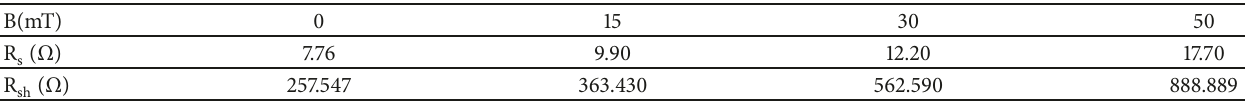
Table 6: Series and shunt resistance of the equivalent circuit of the photovoltaic module as a function of the magnetic field and for a solar irradiance of 600 W/m 2